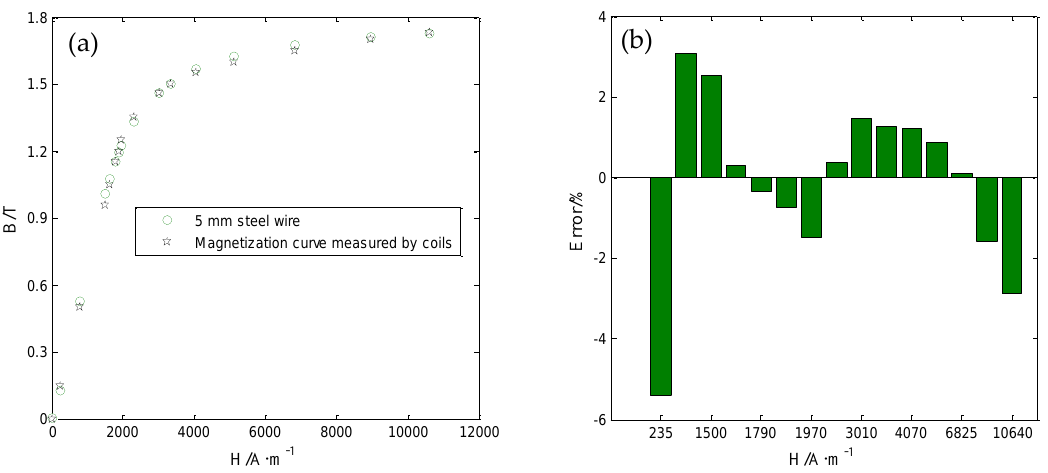
Figure 14. The calculated magnetization curve ( a ) and the corresponding error ( b ).